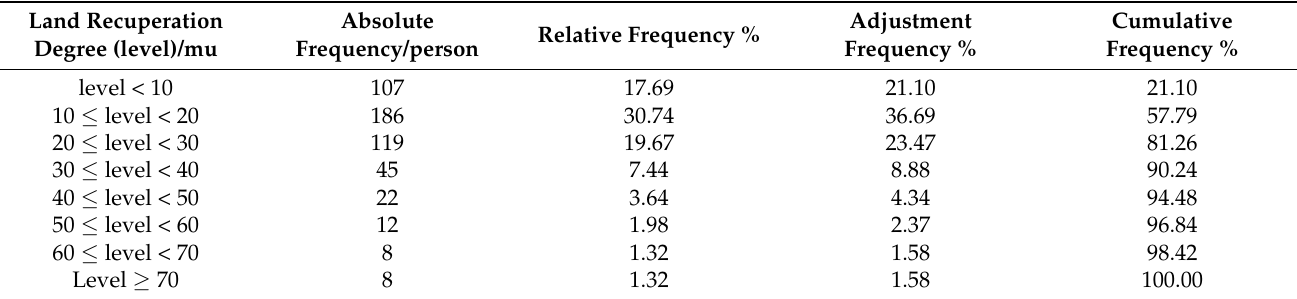
Table 5. Cumulative frequency distribution of subsequent land recuperation degree of land recuperation farmers in the sample.